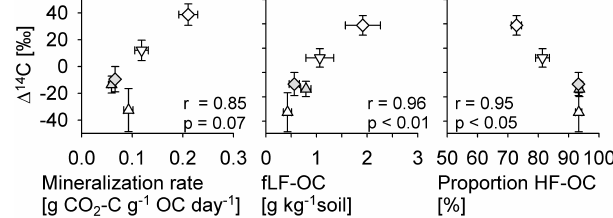
Fig. 12. Relation between average 1 14 C and specific mineralization rates per gOC, amount of OC with the fLF, and the proportion of HF (heavy fraction)-OC at 10–20cm soil depth (only undisturbed sites Hainich, Hesse, Sorø, Bugac, Laqueuille containing no fossil C).